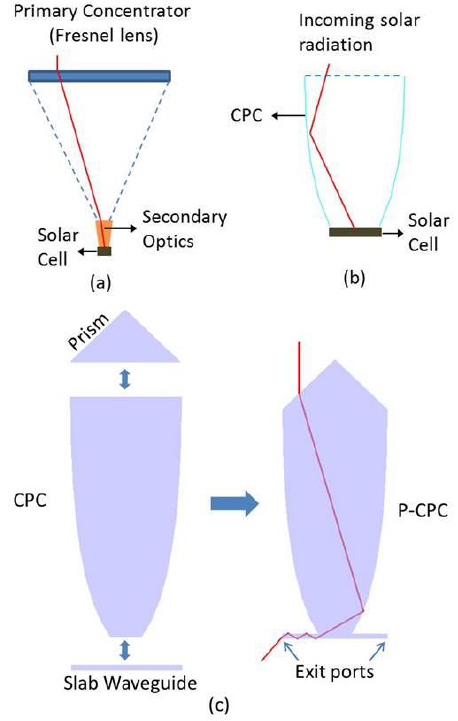
Figure 1. Conventional CPV systems using: ( a ) a Fresnel lens; ( b ) a CPC; ( c ) Solar concentrator using a combination of prism-CPC.